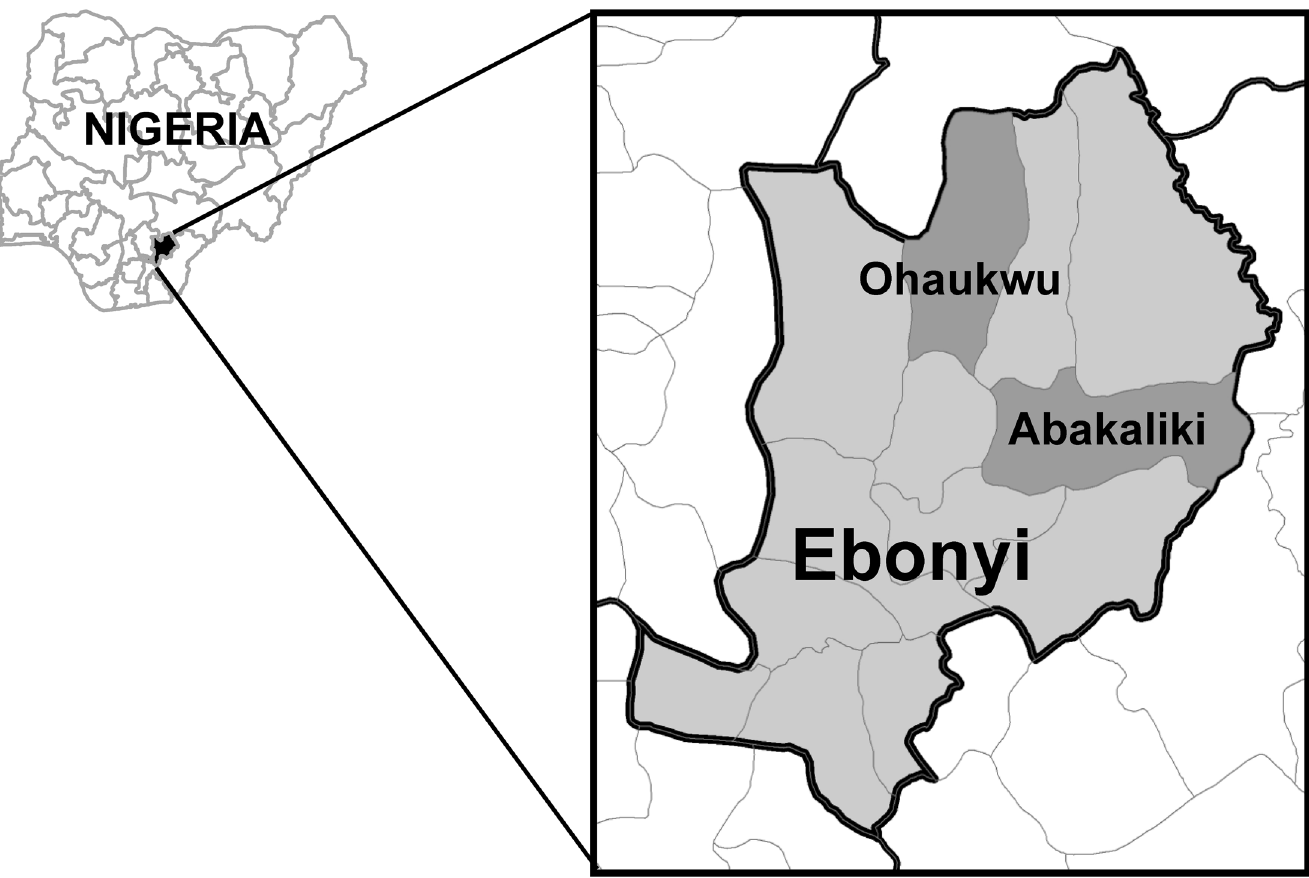
Fig 1. Map of the survey area. Map highlights Ebonyi State in southeast Nigeria, and the Local Government Areas of Ohaukwu and Abakaliki, where the November 2011 survey was